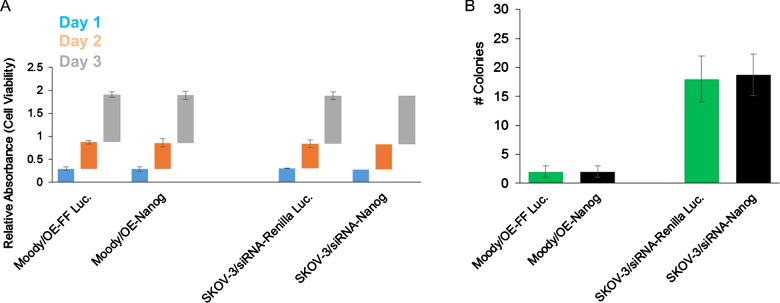
Modulating NANOG expression did not affect in vitro cell proliferation and colony formation(A) Cell viability was measured over 3 days in Moody cells transfected with Firefly luciferase or NANOG expression construct or in SKOV-3 cells transfected with shRNA targeting either Renilla luciferase or NANOG. (B) Moody cells transfected with Firefly luciferase or NANOG expression construct or in SKOV-3 cells transfected with shRNA targeting either Renilla luciferase or NANOG were grown for 2 weeks before being counted by a colony counter. Only colonies greater than 50 μm in diameter were counted as positive. Error bars, S.D.